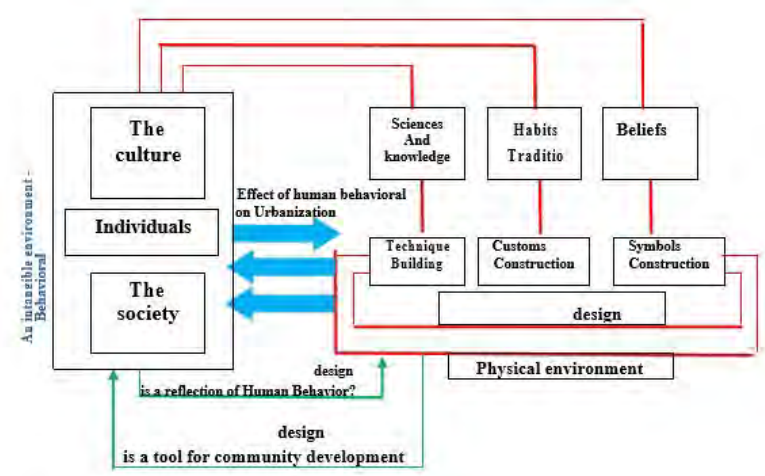
Figure 2. Interrelationship of human behavior and urbanization and their impact on each